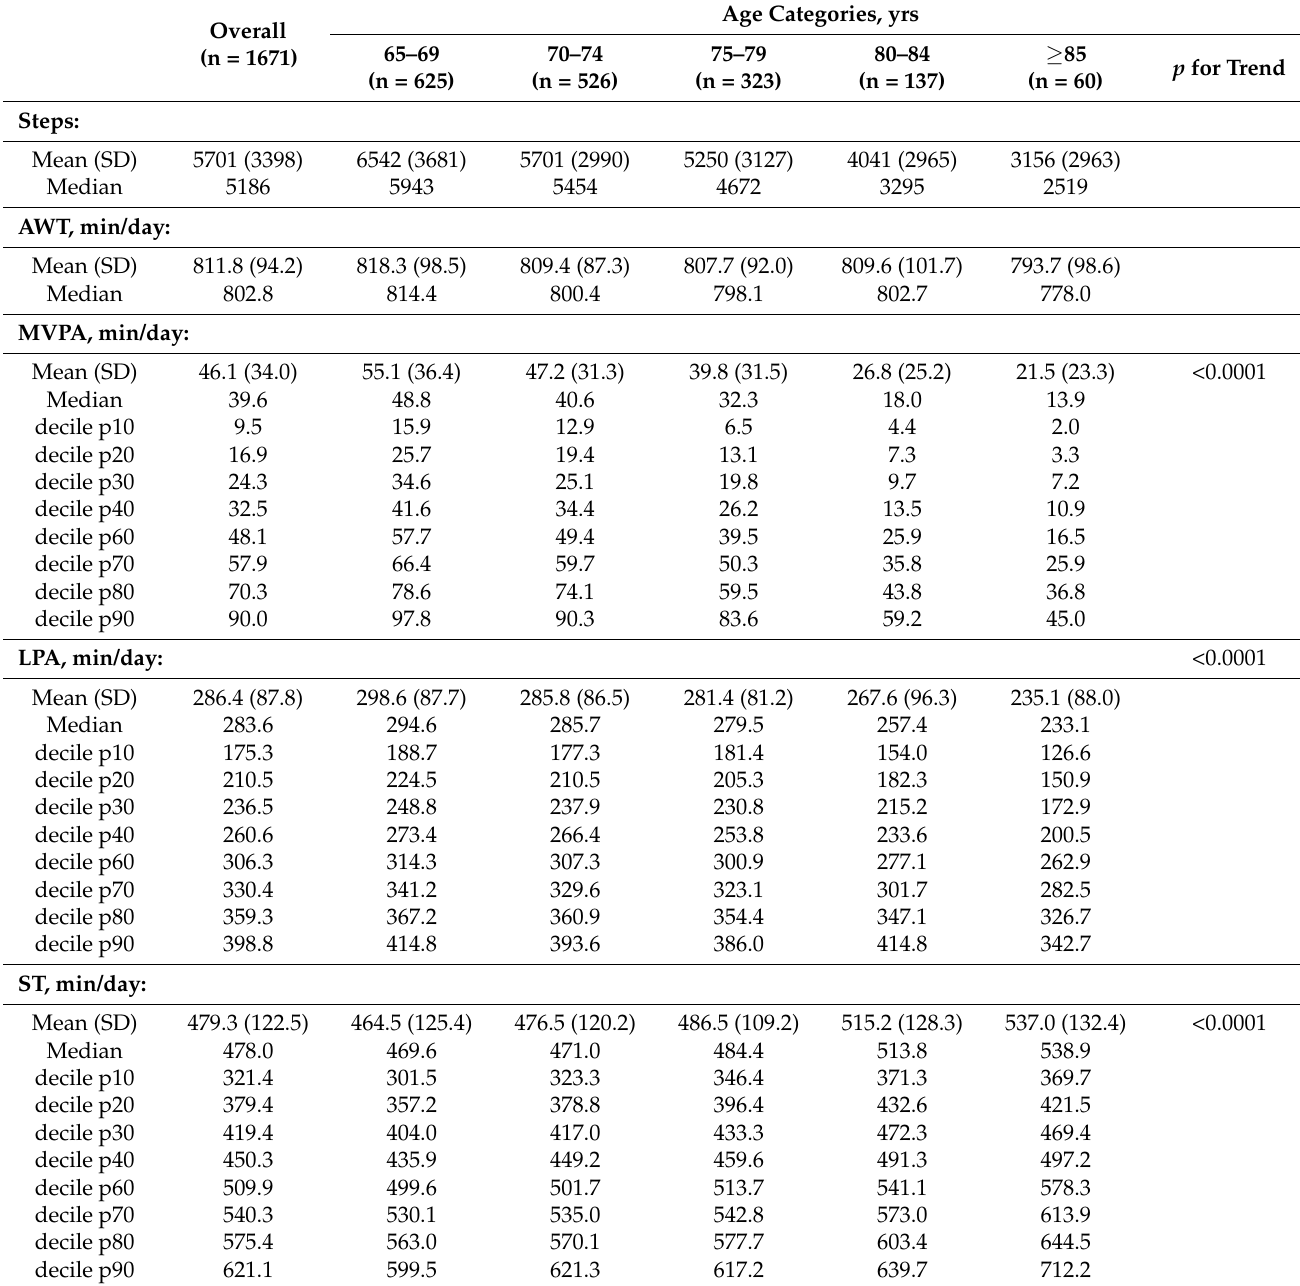
Table 1. Tri-axial accelerometer-determined PA and ST by age groups in the men (n =